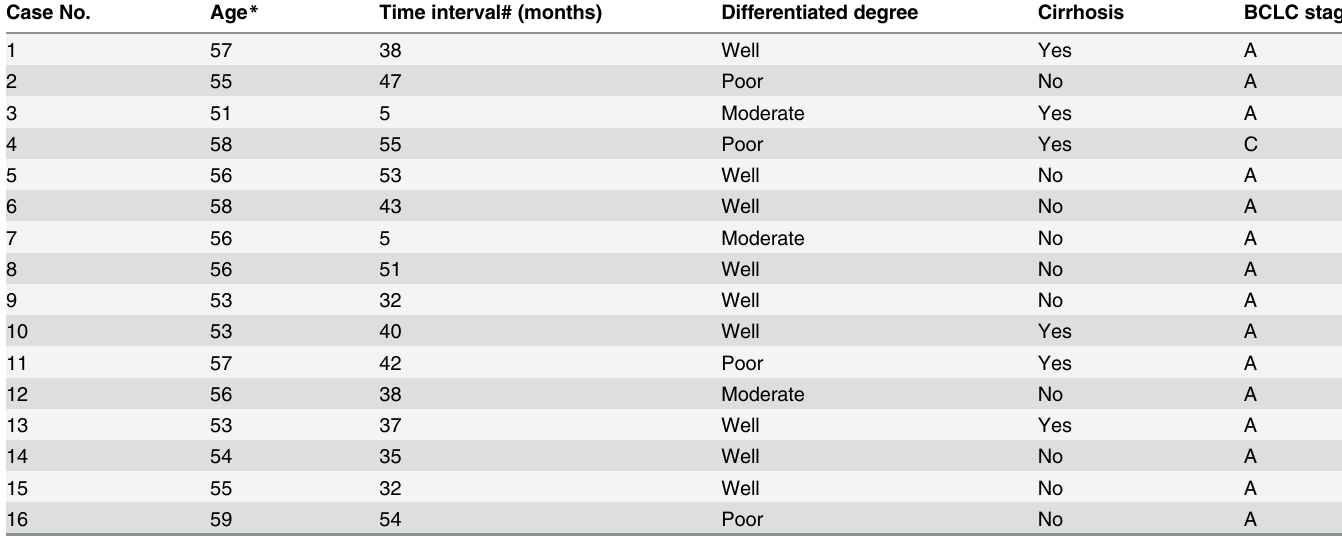
Table 2. Clinicopathological characteristics of the second primary HCC and applied treatment methods. Case